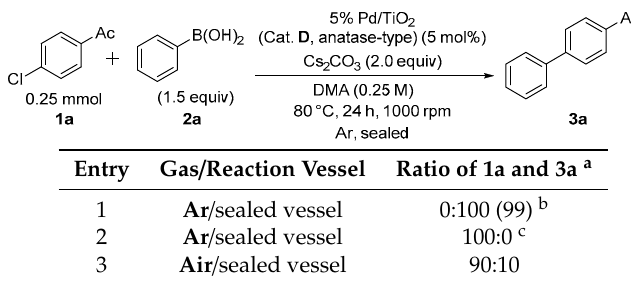
Table 4. Effect of various reaction Table 4. E ff ect of various reaction conditions.